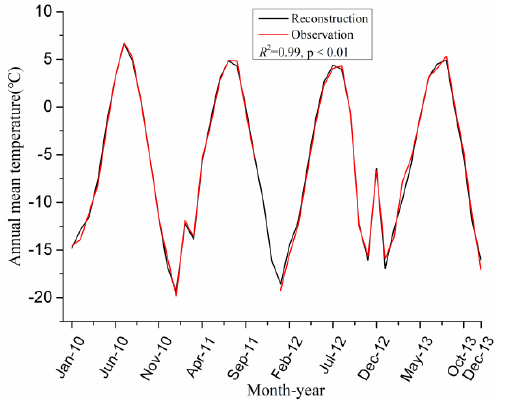
Figure 2. Simulated and observed monthly temperature (T) at AWS1 from 2010 to 2013.